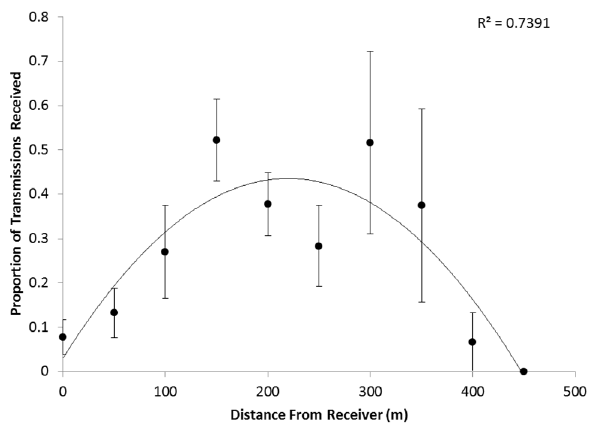
Figure 2. Results of boat-based range testing the WHS 2000 acoustic receivers. Mean proportion of transmissions detected are shown as a function of distance from the receiver, in meters. Error bars are